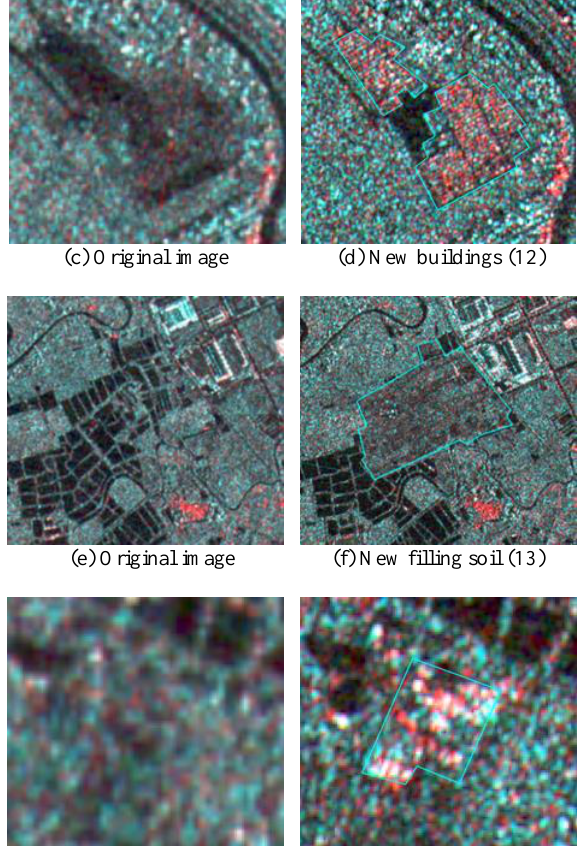
Figure 4. Schematic diagram of typical surface features change information